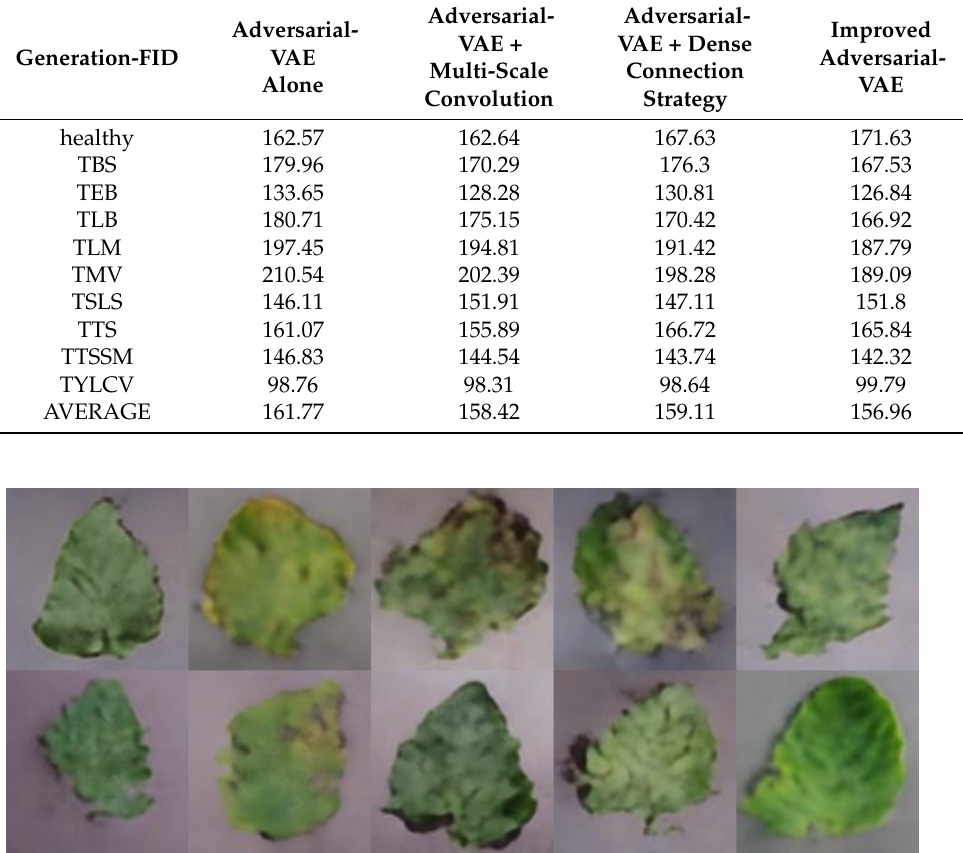
Figure 11. Examples of tomato diseased leaf generated by improved Adversarial-VAE networks: healthy, TBS, TEB, TLB, TLM, TMV, TSLS, TTS, TTSSM, and TYLCV, respectively.